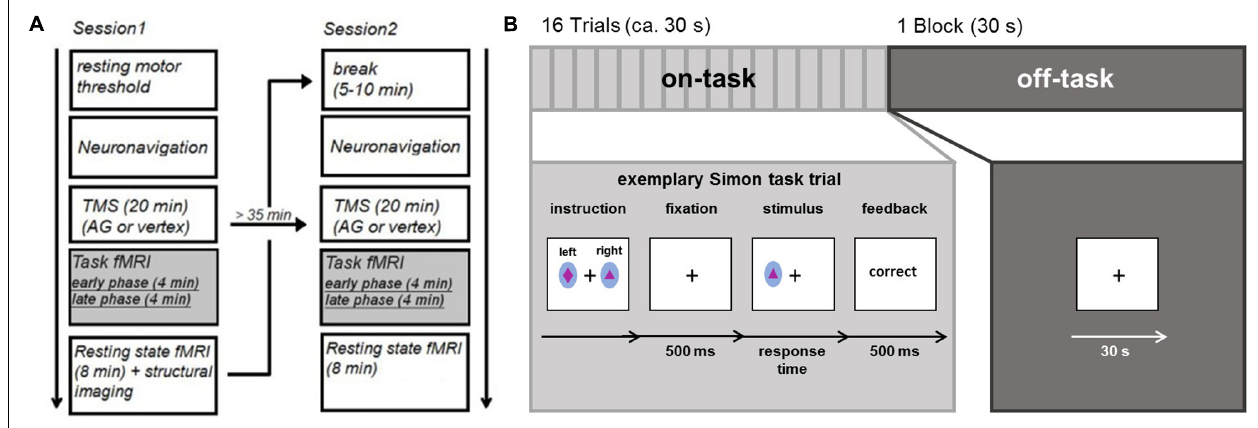
FIGURE 1 | (A) Experimental procedure (B) task fMRI consisting of external attention condition (Simon task) and internal attention